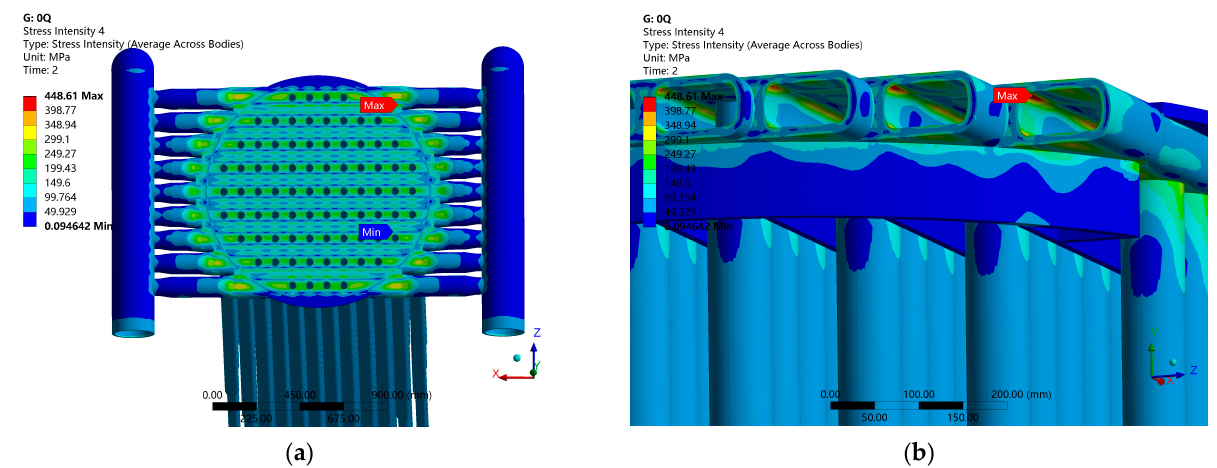
Figure 4. ( a ) Stress intensity distribution and ( b ) maximum stress on the upper flat-round tubesheet under load case 1 without prestretching of the tubes. under load case 1 without prestretching of the tubes.